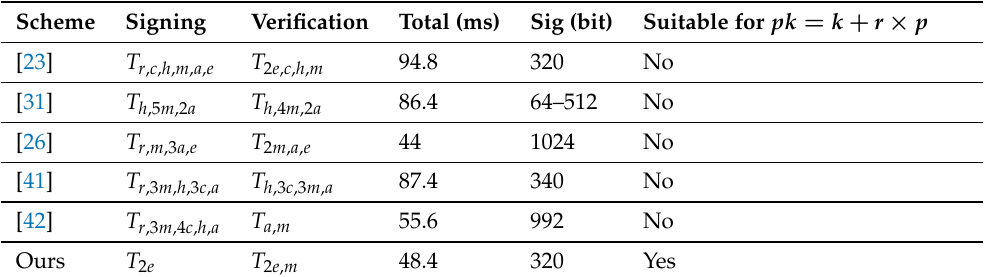
Table 4. A comparison of the computation cost and size.